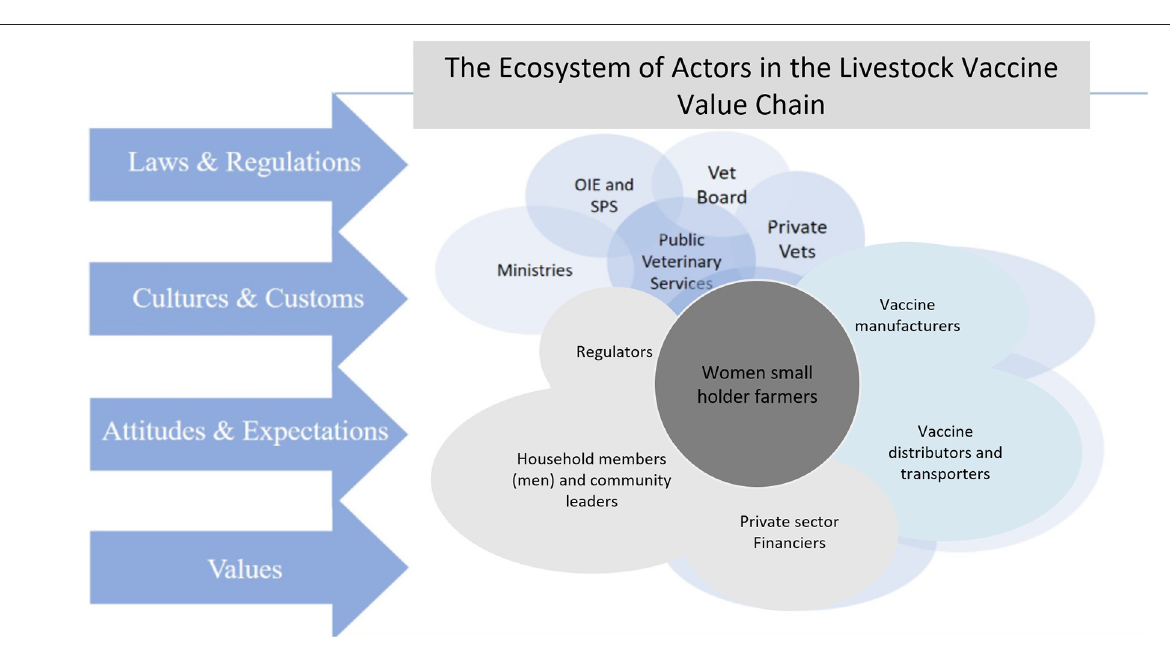
Frontiers in Global Women’s Health |